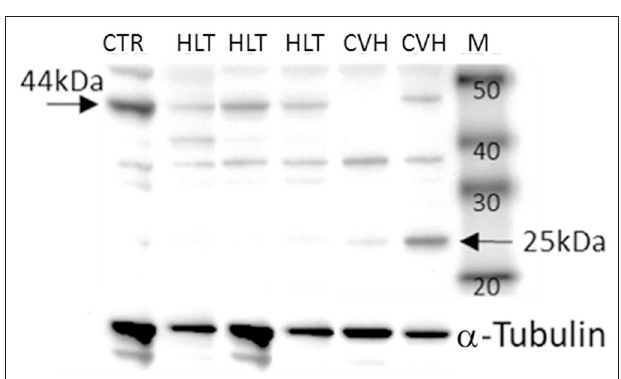
FIGURE 4 | Representative image of Western blots of PAR 2 proteins and the reference proteins, α -tubulin, in the horses during colon volvulus (CVH group) and in the colons of the healthy horses (HLT group). CTR: positive control for PAR 2 (healthy jejunum tract); M: Molecular weight marker (kDa).